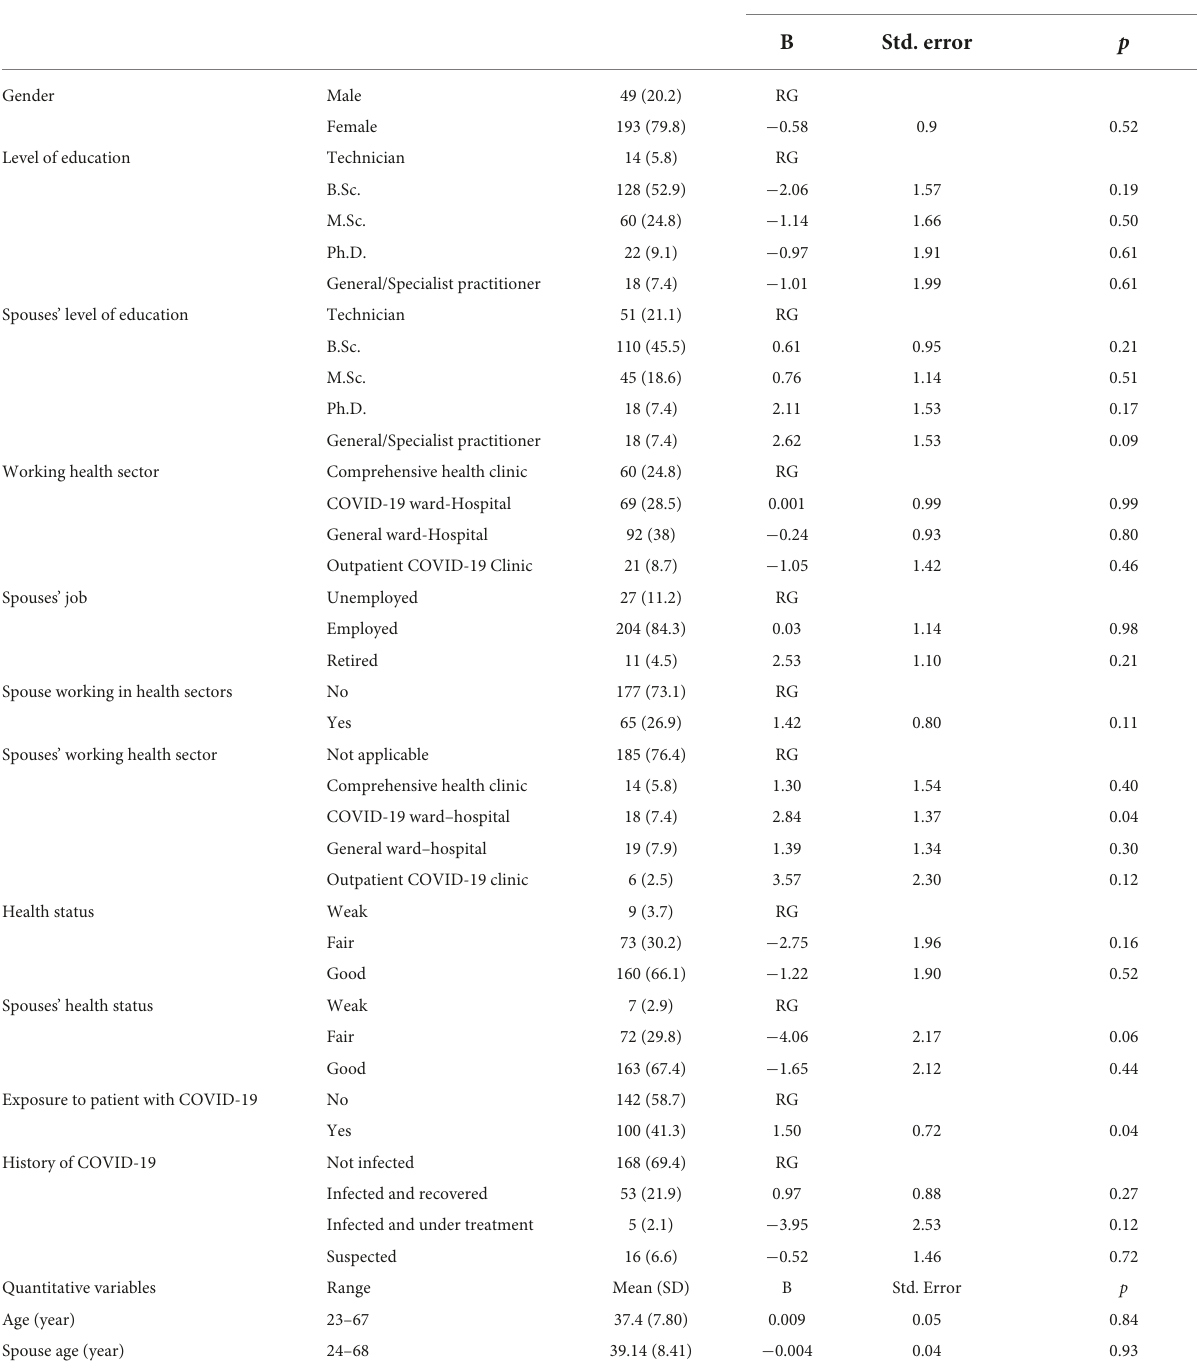
TABLE 1 Socio-demographic and main independent variables and univariable logistic regression analysis considering communal coping as a dependent variable. Qualitative variables No (%) Univariable linear regression analysis B Std. error